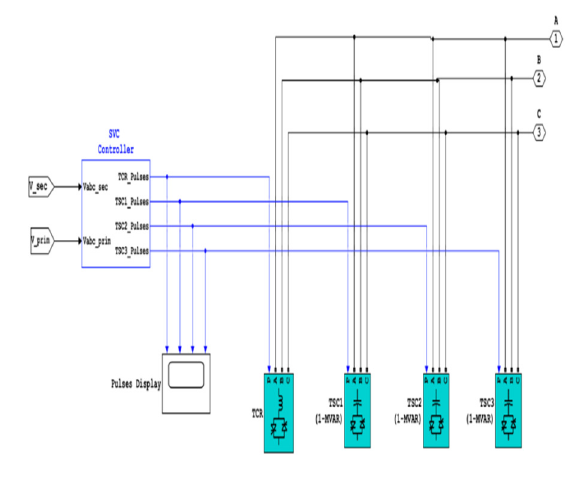
FIG. 4. INSIDE VIEW OF SVC CONTROLLER